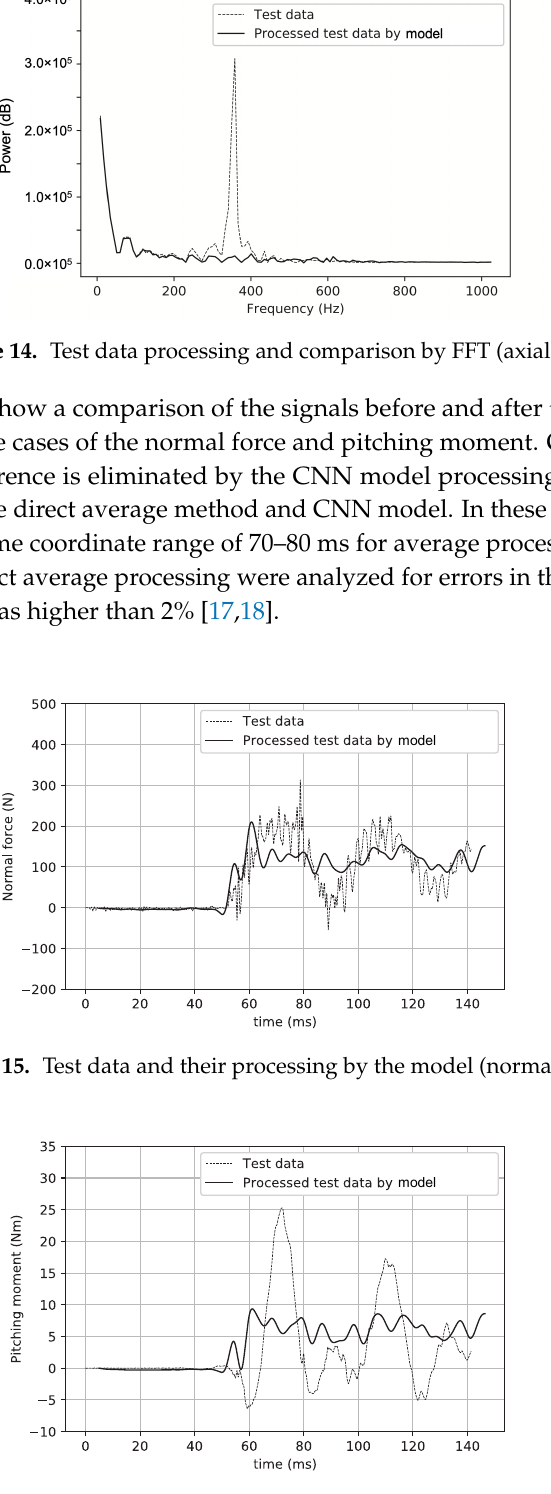
Figure 16. Test data and their processing by the model (pitching